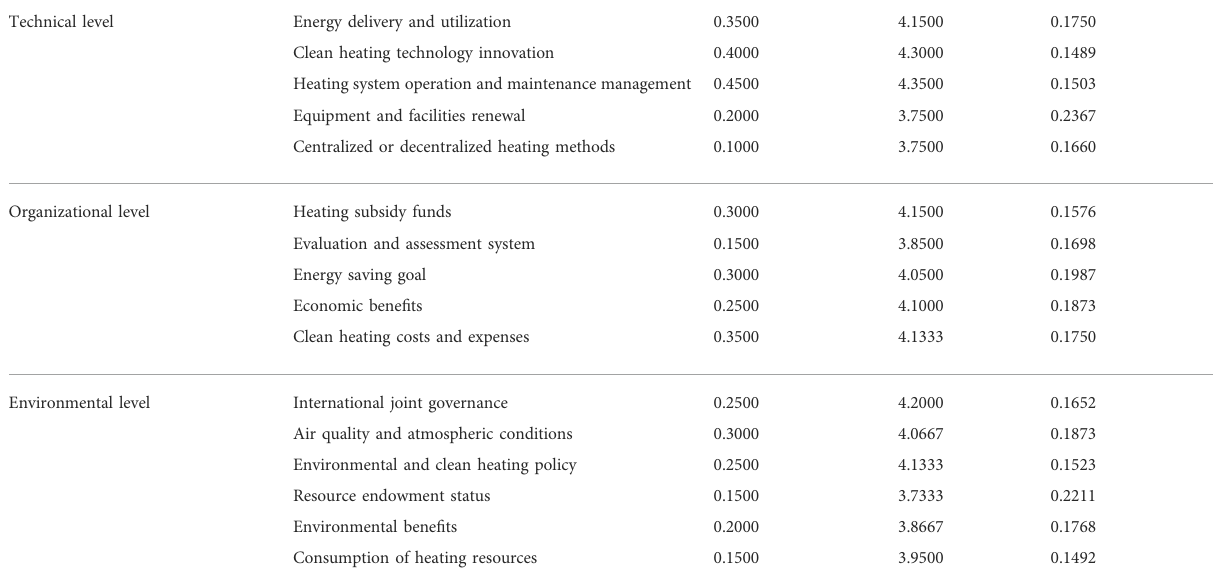
TABLE 3 Scores of indicators related to in fl uencing